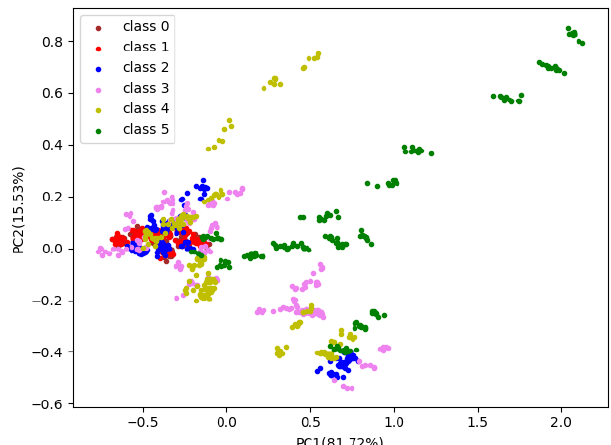
Figure 5. Projections of the two first primary components of the PCA computed on training set to determine the levels of pear browning. The horizontal axis represents the principal component 1 with 81.72% contribution rate and the vertical axis represents the principal component 2 with 15.53%.